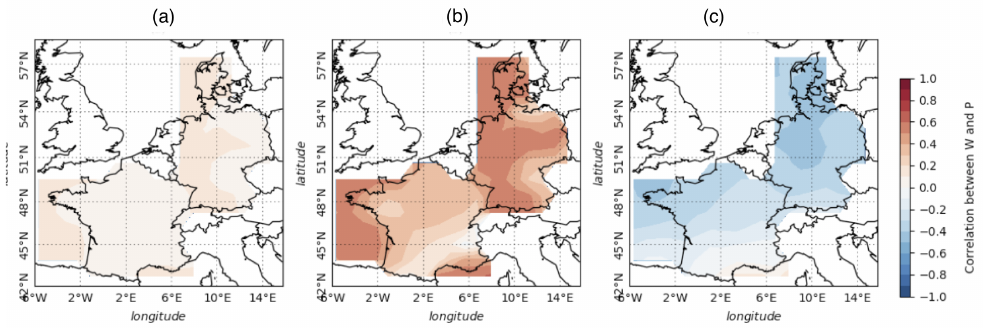
Figure 3. Pearson correlation between prices and production: ( a ) hourly mean, ( b ) monthly mean, and ( c ) yearly